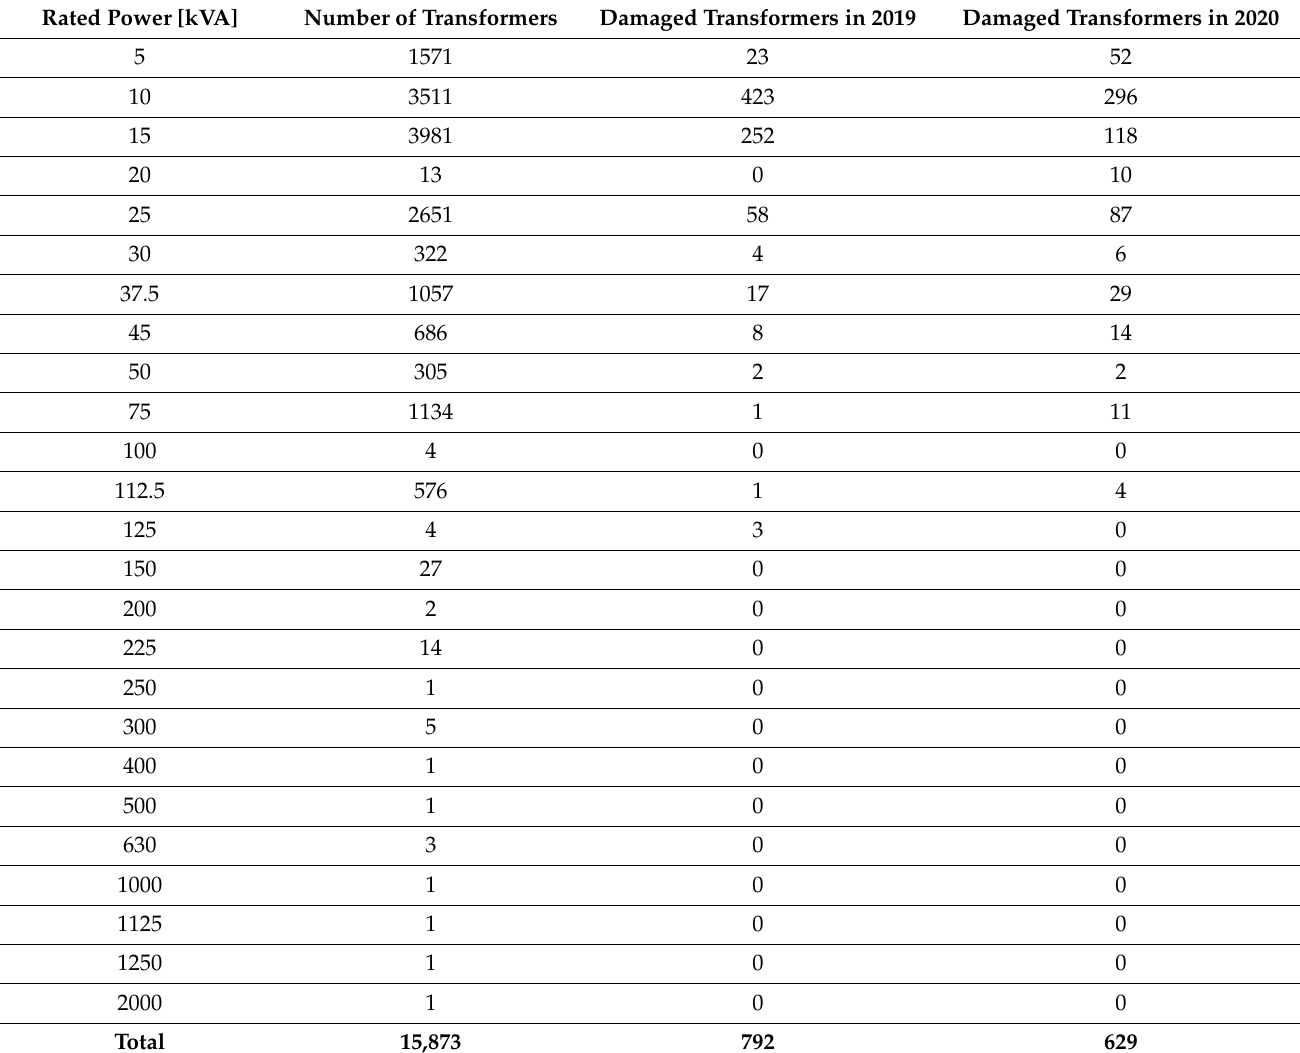
Table 2. Transformer data and number of burned transformers for 2019 and